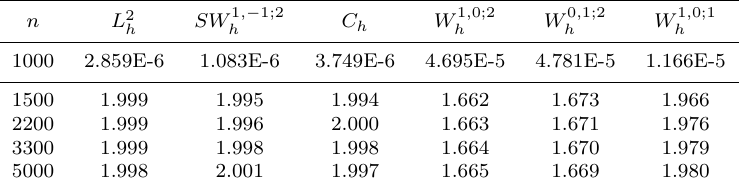
Table 6. Practical errors and error orders in Example A 7 / 2 n